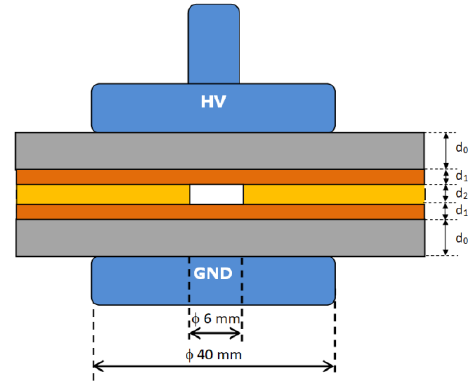
Figure 4. S pecimen with electrodes. Figure 4. Specimen with